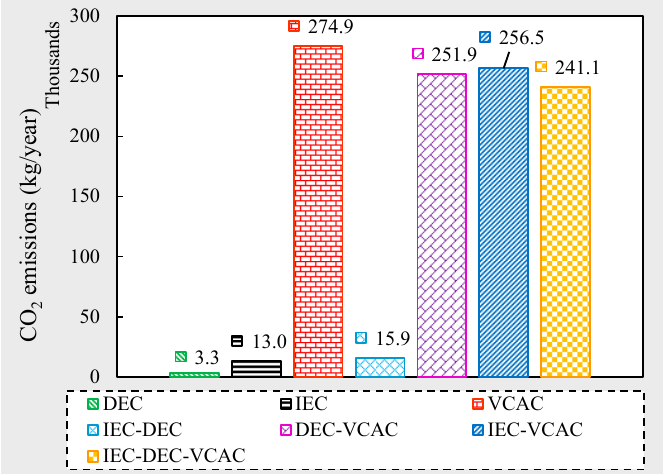
Figure 13. Annual energy nexus–sensible heat gains from different sources in the building.